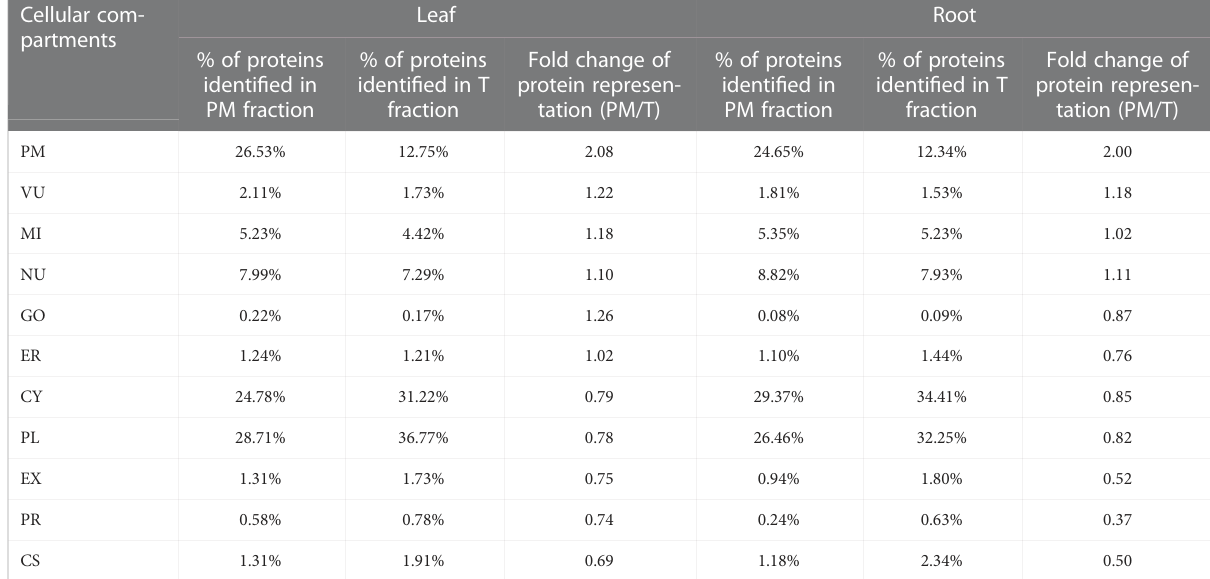
TABLE 3 Comparison of organelle proteomes between total protein and enrichment fraction. Cellular